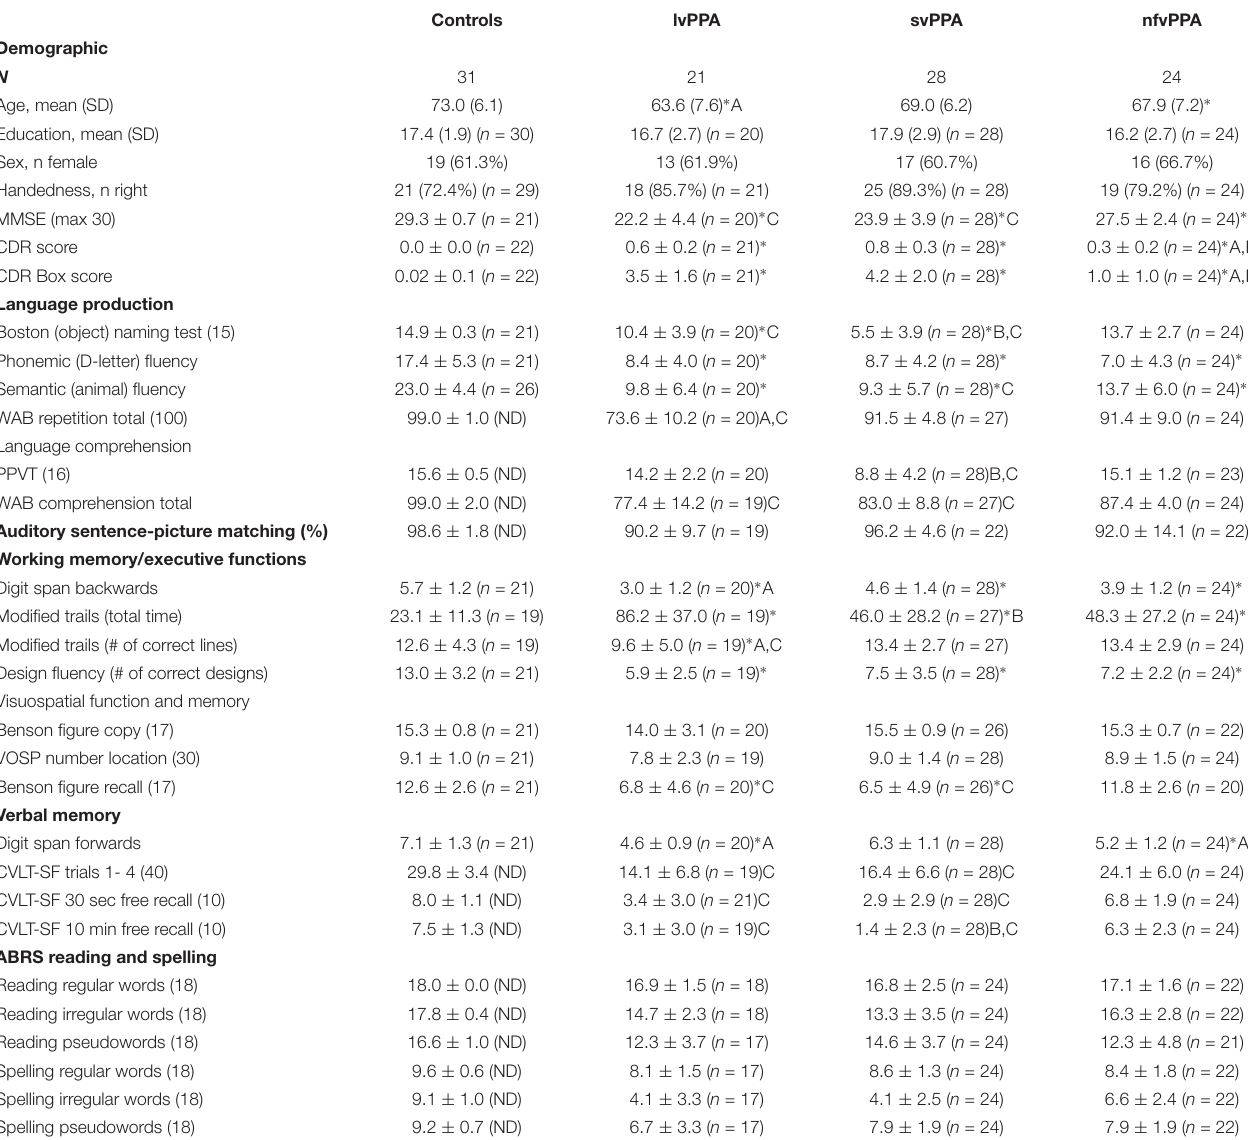
TABLE 1 | Participants demographic and neuropsychological